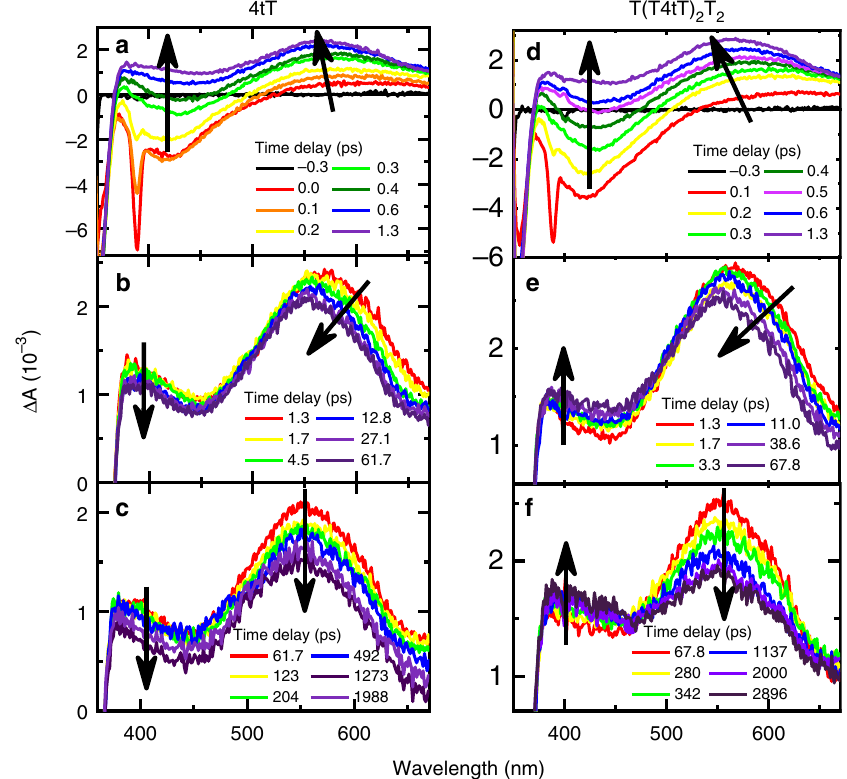
Fig. 4 Broadband transient-absorption spectra for 4tT and T(T4tT) 2 T 2 . Left panel (i.e., a – c ) depicts the transient data for the 4tT nucleoside, while the right panel (i.e., d – f ) shows the transient data for T(T4tT) 2 T 2 both in PBS pH 7.4 upon excitation at 342 nm. Stimulated Raman emission from the water solvent is observed at 385 nm within the cross-correlation of the pump and probe beams in both data sets (i.e., panels a and d ), and its maximum amplitude was used to de fi ne the time delay equal to zero picoseconds. The transient-absorption spectra are represented with solid lines using a rainbow of colors. Black arrows indicate the transition of the absorption bands as a function of time delay and are used as a guide to the